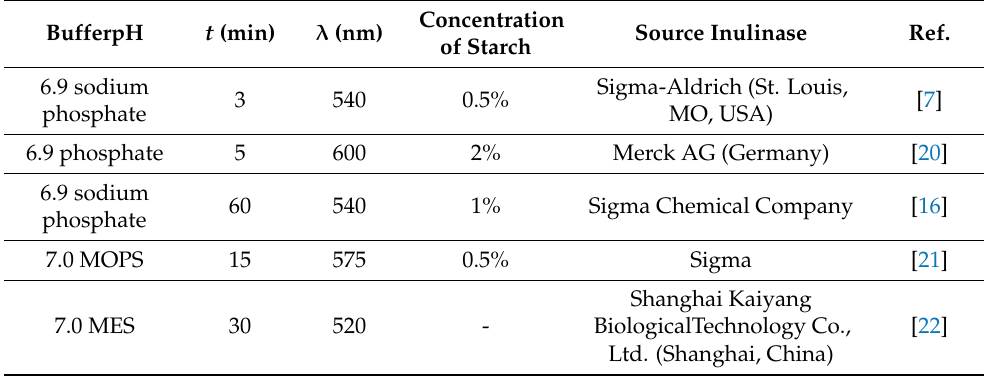
Table 3. Conditions for measuring α -amylase porcine pancreas activity. Concentration Source Inulinase Ref. BufferpH t (min) λ (nm) of Starch Sigma-Aldrich (St. Louis, 6.9 sodium 3 540 0.5% MO, phosphate